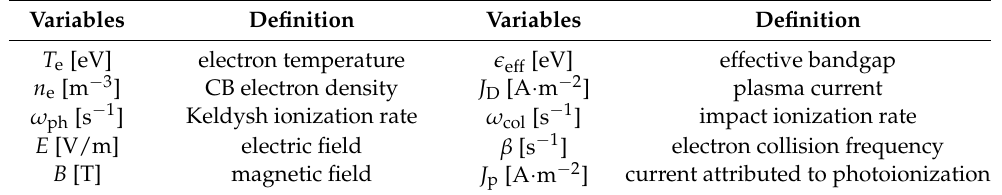
Table 2. Nomenclature of derived variables in FDTD